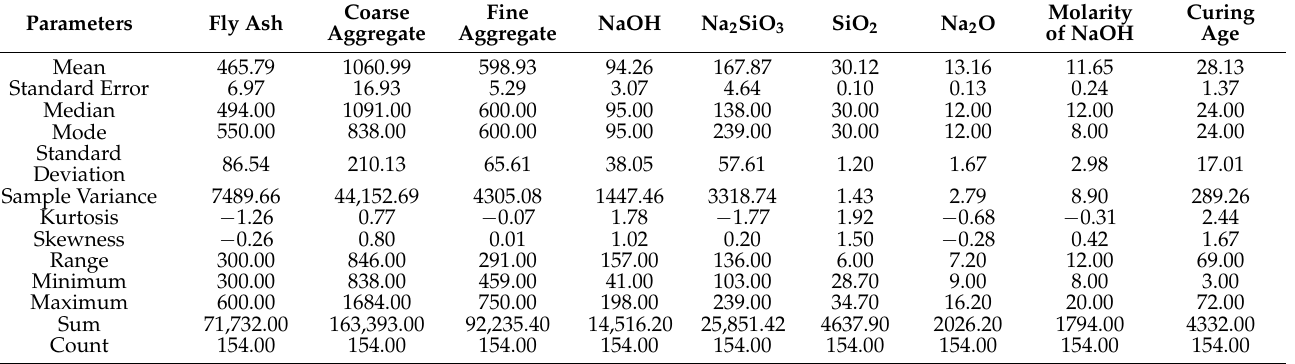
Table 2. Descriptive analysis of the input